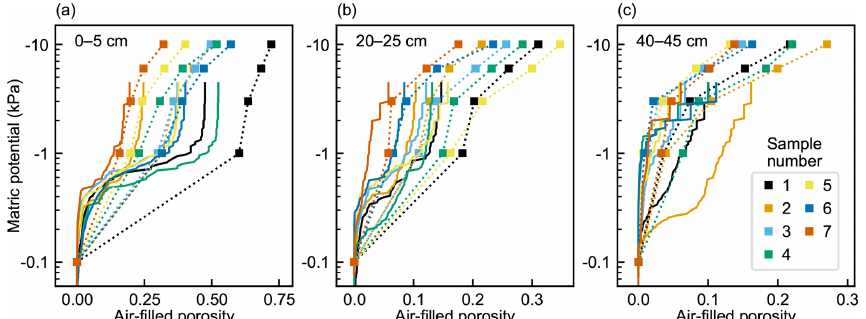
Figure 4. Measurement-derived (square markers with dotted connecting lines) air-filled porosities of peat samples from (a) 0–5cm, (b) 20– 25cm, and (c) 40–45cm depths at different matric potentials and the corresponding simulated air invasion curves (solid lines). Air-filled porosity was determined by subtracting the measured volumetric water content (Eq. 1) from total porosity (Eq. 2). The measurement-derived air-filled porosities at − 0.1kPa are set to 0 in the plots, which corresponds to the initial state of the water retention simulation.